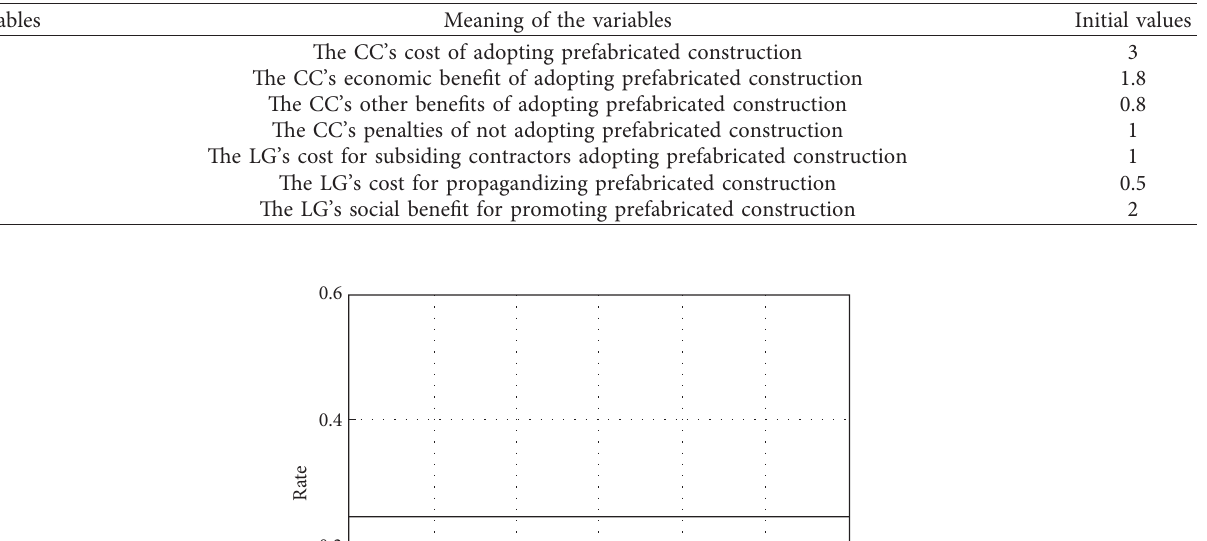
Figure 1: SD model of the evolutionary game between the CC and LG for prefabricated promotion. Table 3: Initial values of external variables.